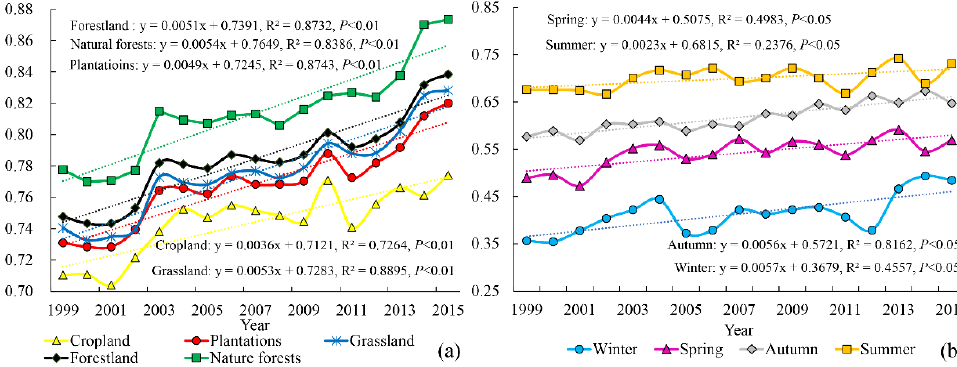
Figure 5. Variations of NDVI in the MRYR from 1999 to 2015. ( a ) mean NDVI of different vegetation in different years; ( b ) mean NDVI of all vegetation in different seasons.